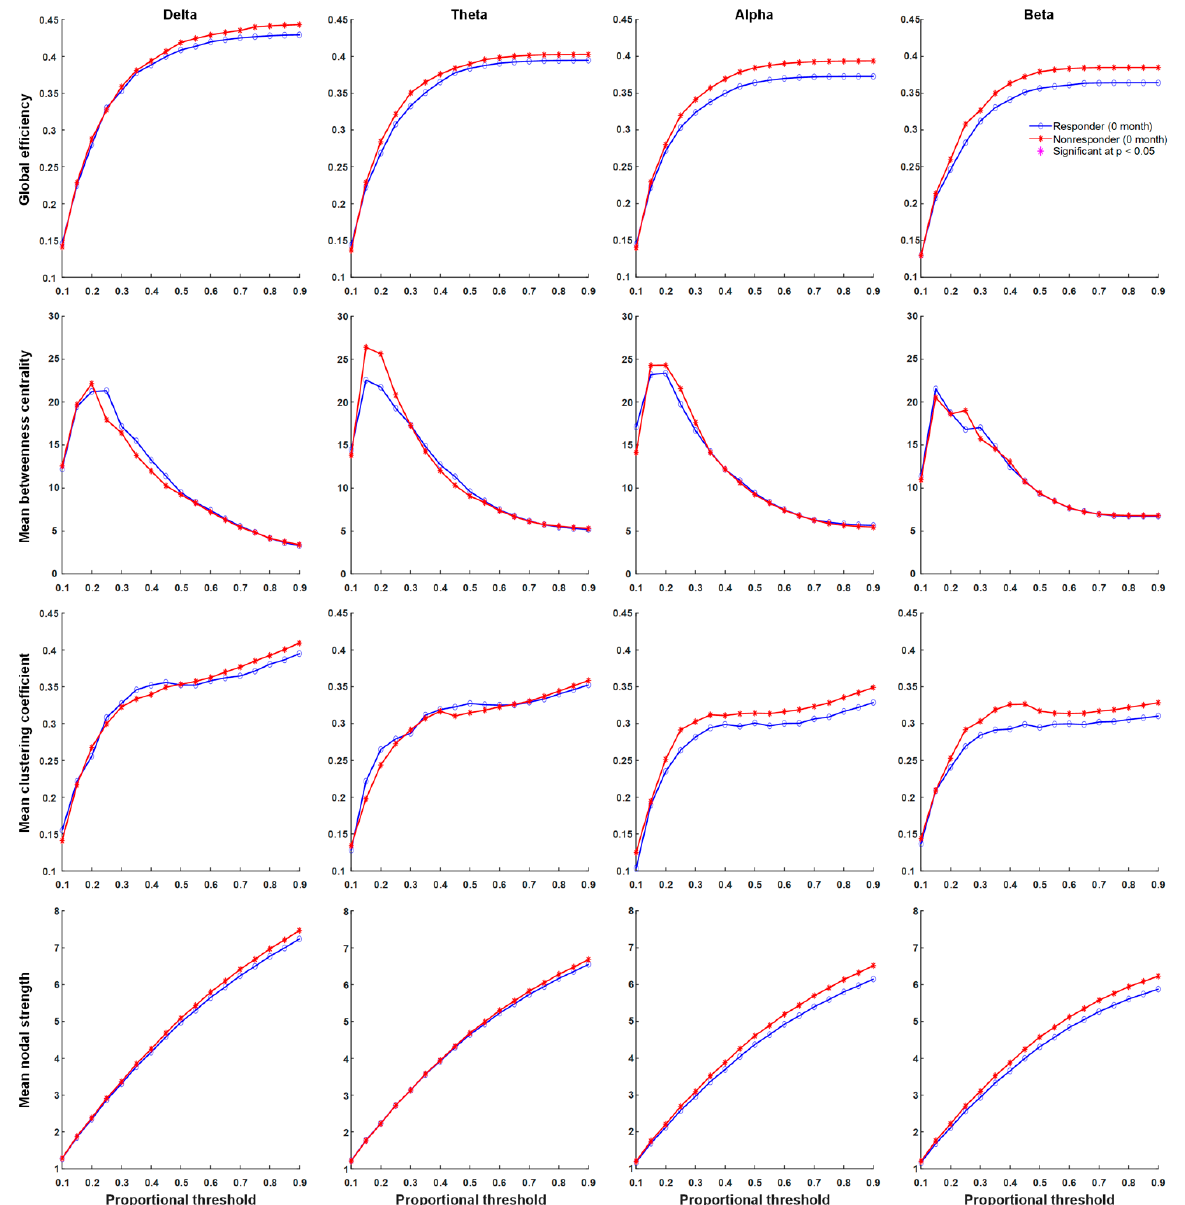
Figure 2. Graph theory-based analyses between responders and non-responders before KDT show global efficiency, mean clustering coefficient, mean nodal strength, and mean betweenness centrality in delta, theta, alpha, and beta frequency bands. Responders had decreased rather than increased connection strength in delta, alpha, and beta frequency bands compared with values before KDT. Asterisks denote statistically significant differences ( p < 0.05). (KDT: ketogenic diet therapy.)